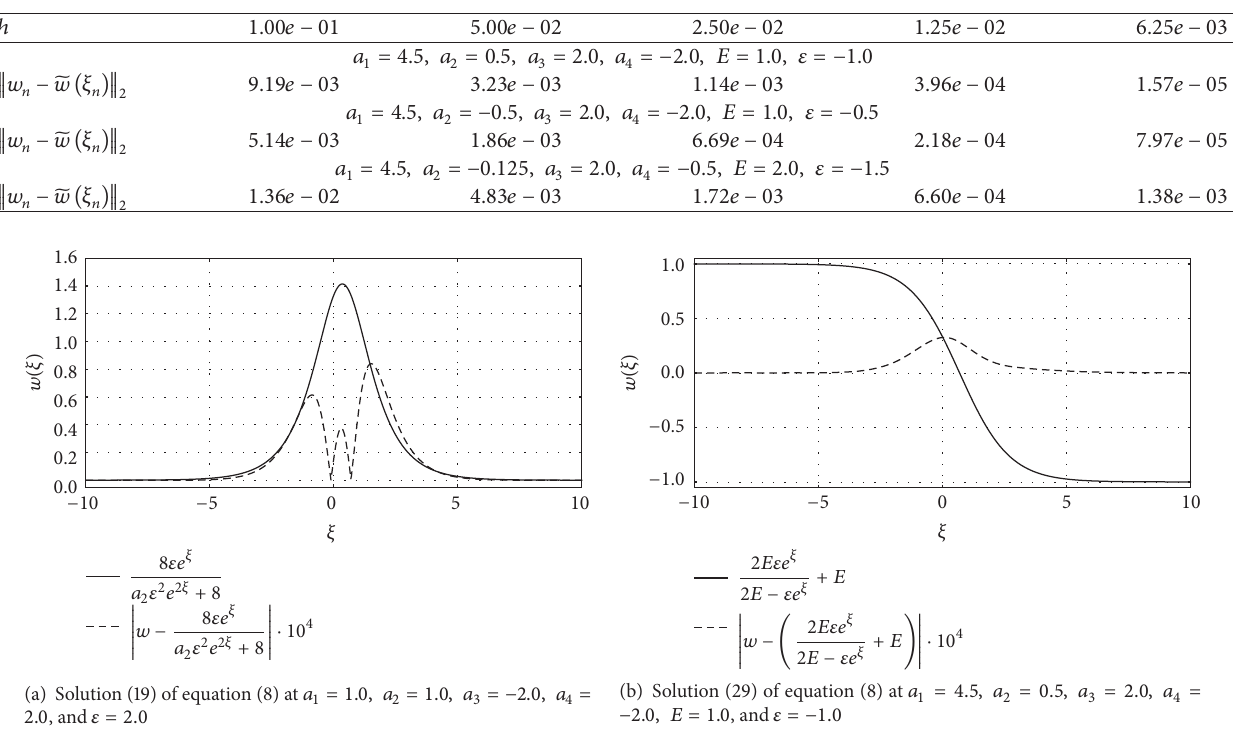
Table 2: Deviations of the numerical solution 𝑤 𝑛 from the exact solution ̃𝑤(𝜉 𝑛 ) (29). ℎ